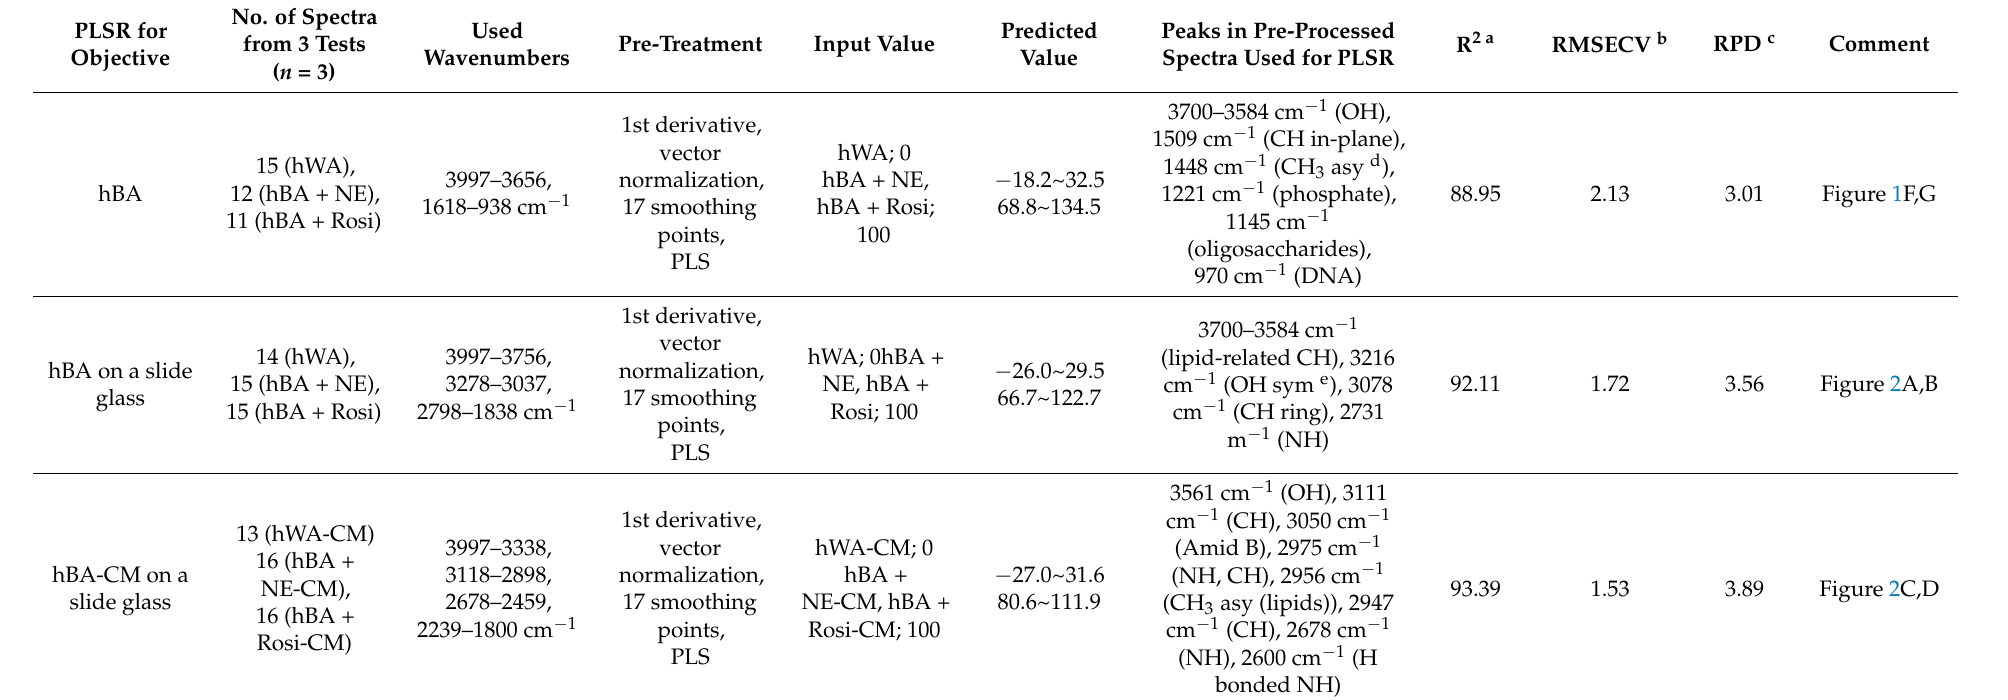
Table 2. Comparing PLSRs using FTIR spectra of human